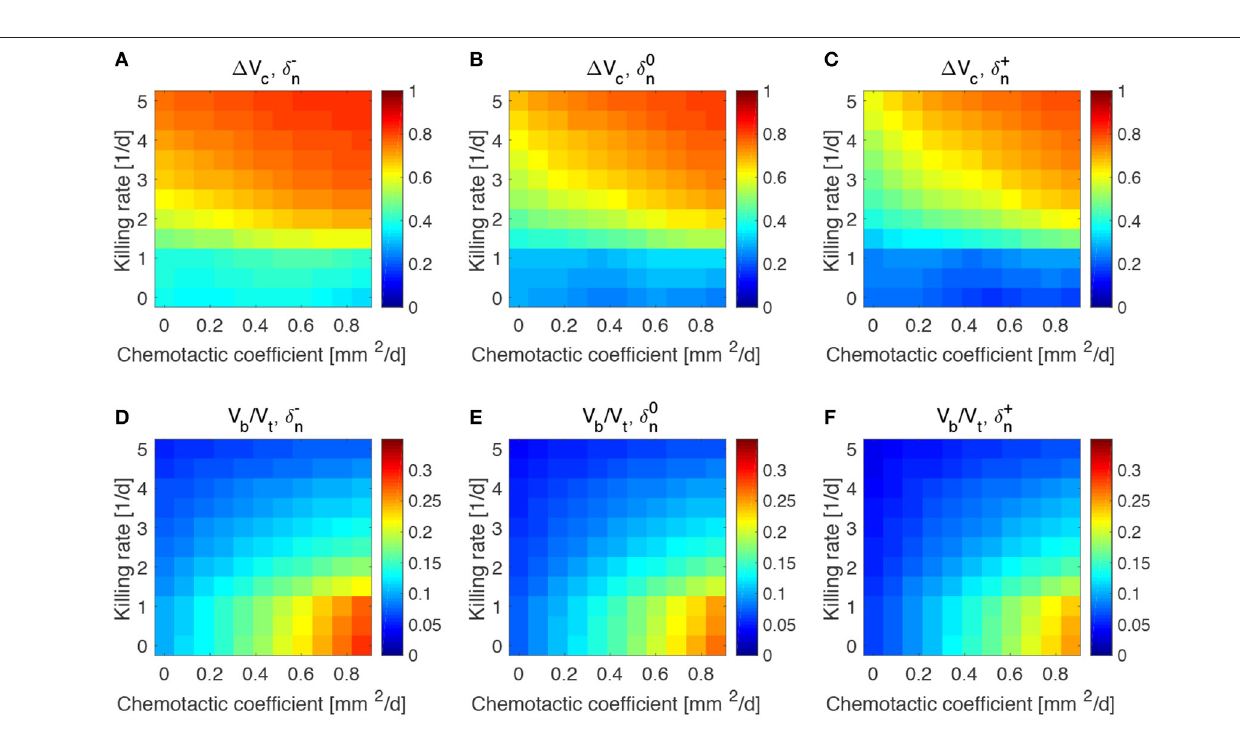
Frontiers in Microbiology | www.frontiersin.org